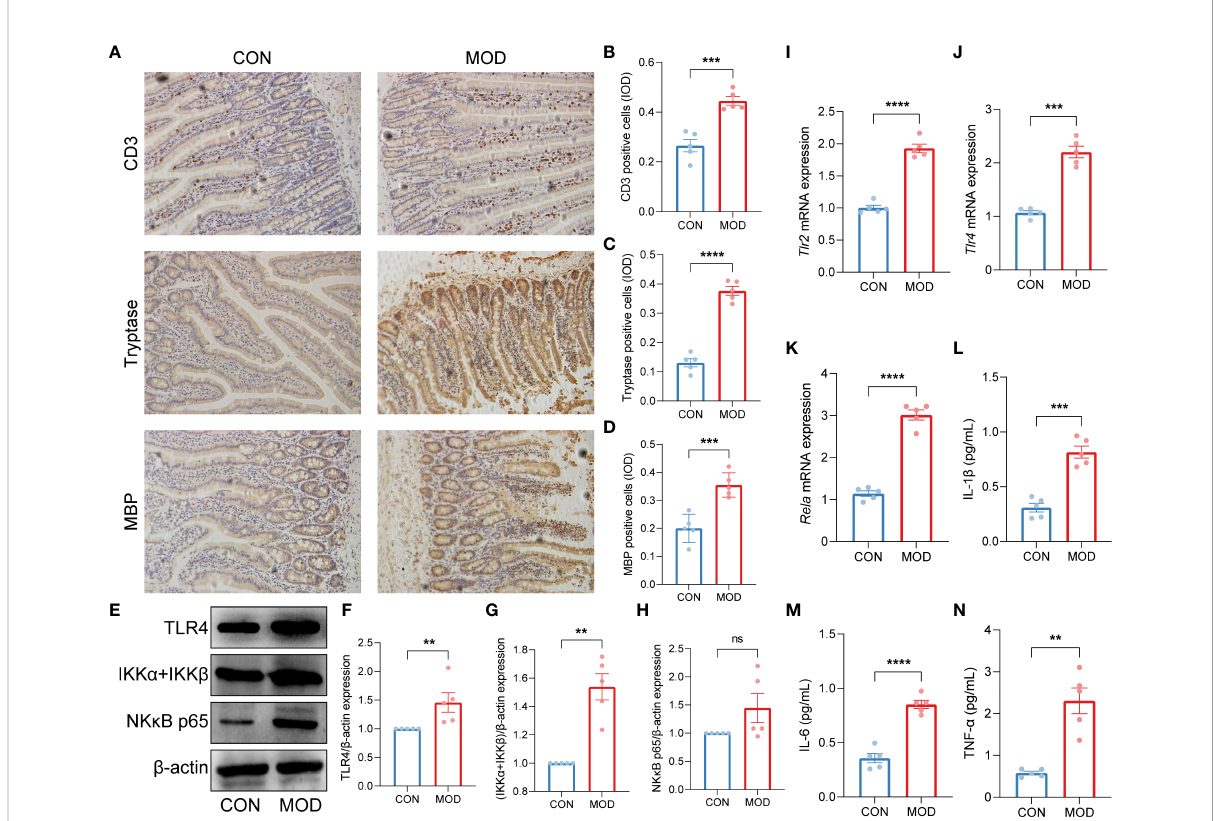
FIGURE 5 Validation of innate immune cells-mediated TLR2/TLR4-NF k B signaling pathway. (A-D) Duodenal immunohistochemical staining (A) and the relative expression (IOD) of CD3-labeled T lymphocytes (B) , tryptase-labeled mast cells (C) and MBP-labeled eosinophils (D) (*** p < 0.001, **** p < 0.0001 by unpaired t test with Welch ’ s correction). (E-H) The WB bands (E) and scaled normalized protein expressions of TLR4 (F) , IKK a + IKK b (G) and NK- k B p65 (H) (** p < 0.01 by Mann Whitney test, ns indicates not signi fi cant). (I-K) The relative mRNA expressions of Tlr2 (I) , Tlr4 (J) and Rela (K) (*** p < 0.001, **** p < 0.0001 by unpaired t test with Welch ’ s correction). (L-N) The plasma contents of proin fl ammatory cytokines IL-1 b (L) , IL-6 (M) and TNF- a (N) (IL-1 b and IL-6: *** p < 0.001, **** p < 0.0001 by unpaired t test with Welch ’ s correction; TNF- a : ** p < 0.01 by Mann Whitney test) ( n = 5